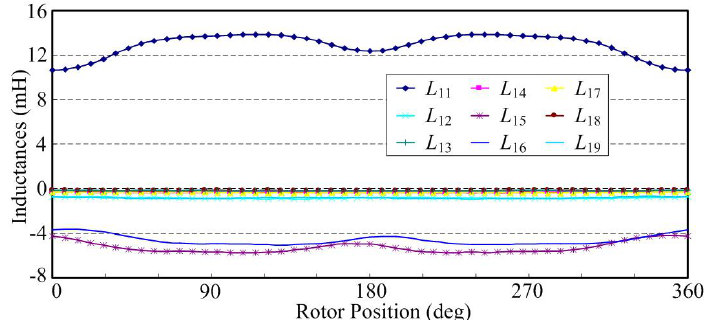
Figure 3. Self- and mutual inductances in phase